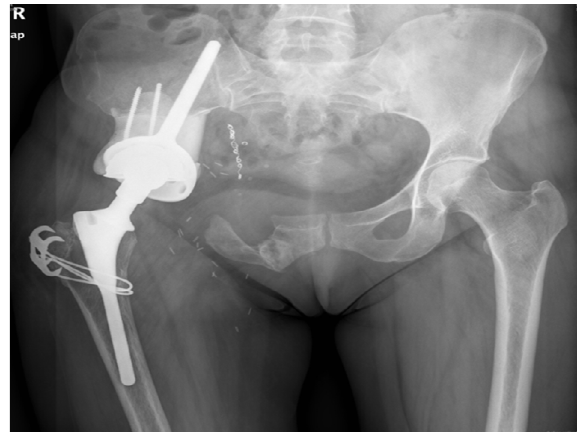
Figure 2. Radiographic result at 3-year follow-up.